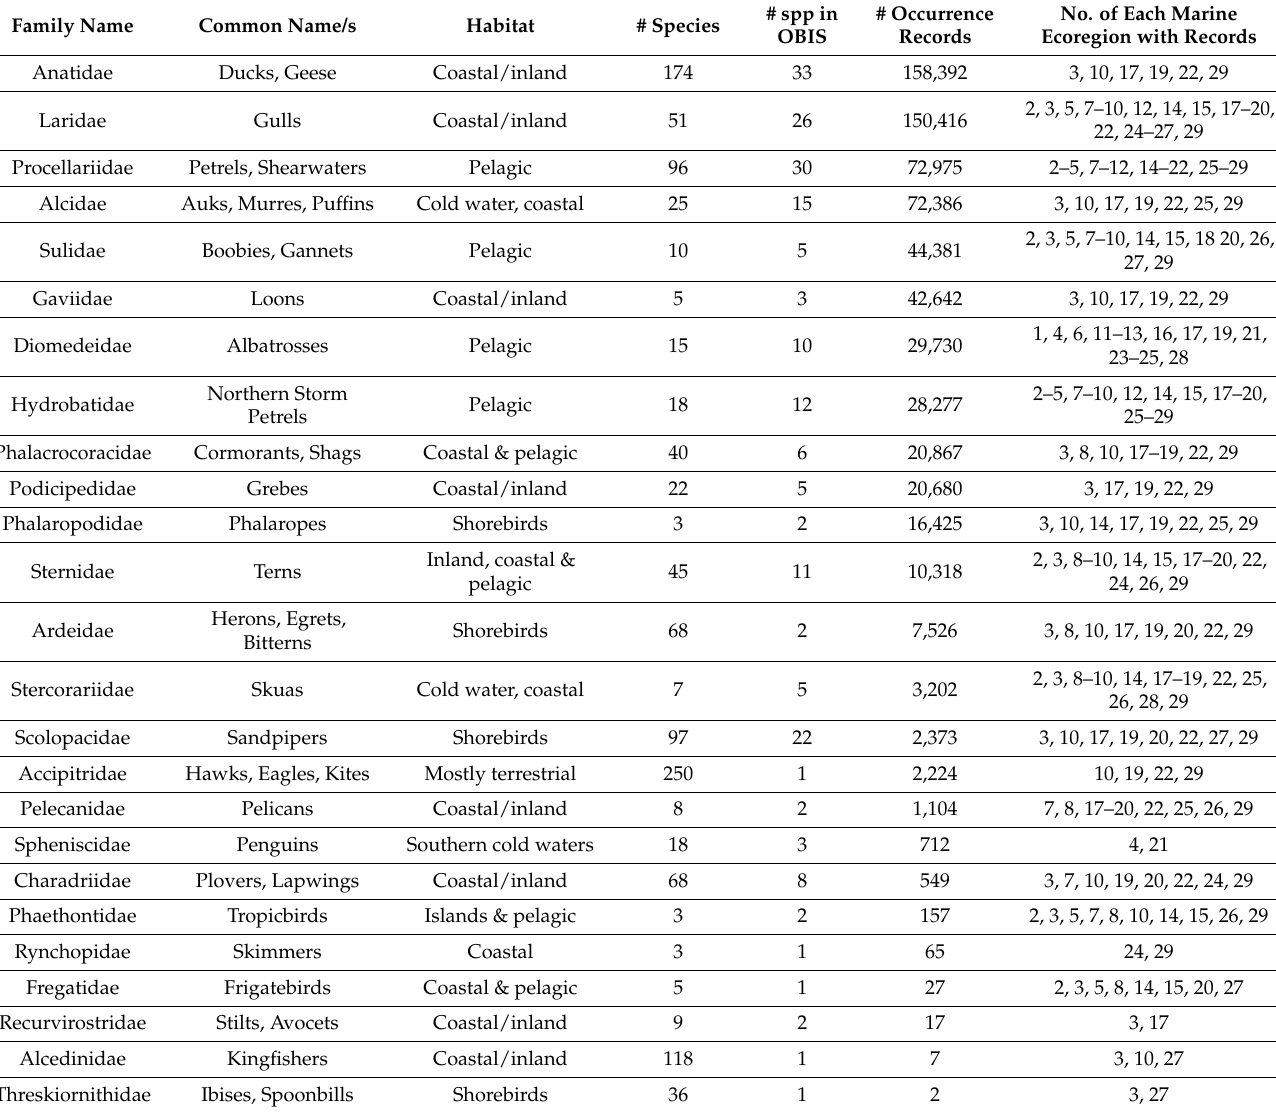
Table 1. Sea- and shorebird families, common names, general habitat, number of species recognized based on ([20–40] and occurrence records within the OBIS database [7]). The ecoregions with records were alphabetically assigned numbers (1–29) to show where records for each family were